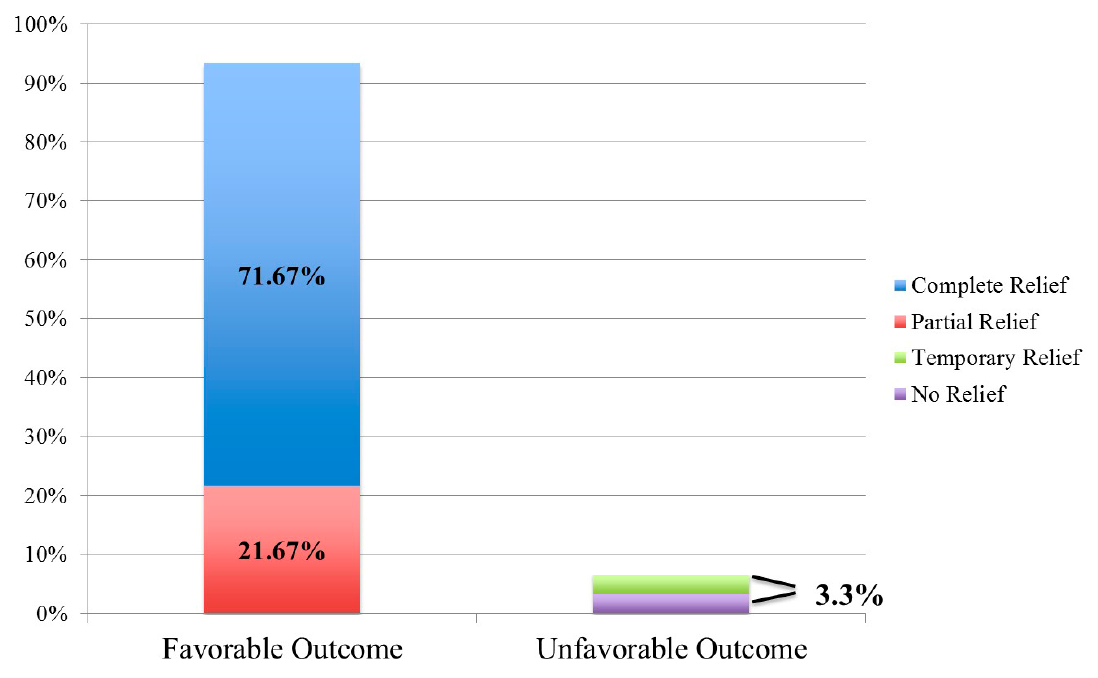
Figure 1. Response following first rib resection (FRR).